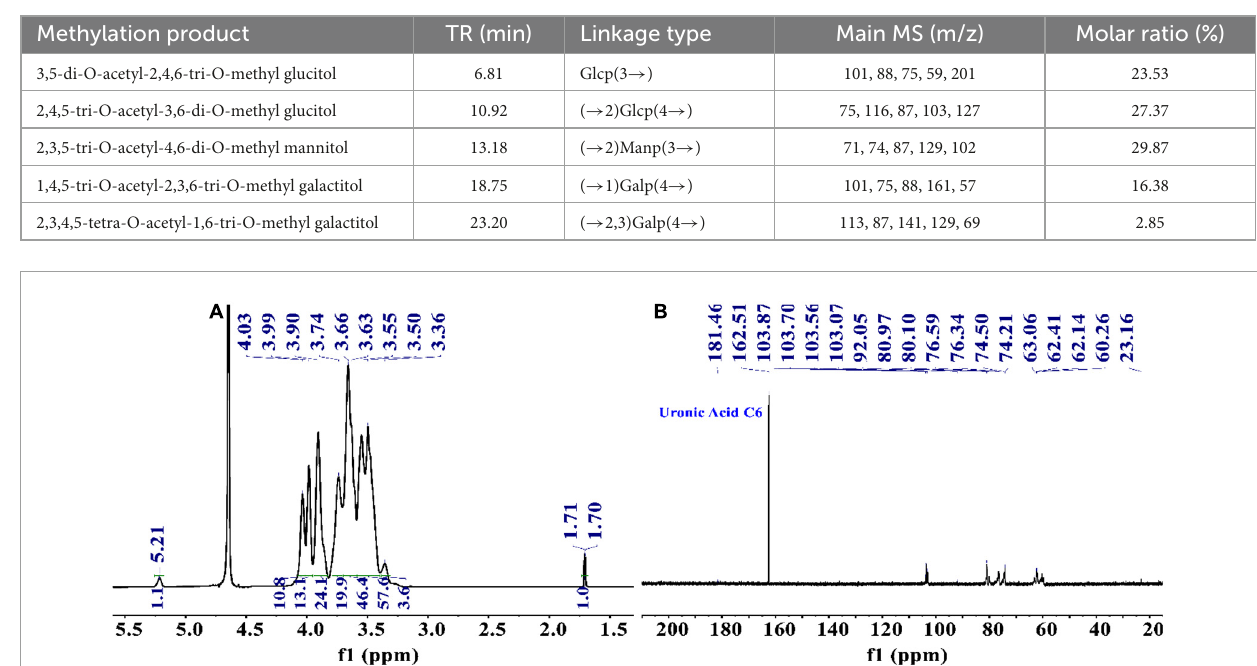
HSQC, HMBC, and NOESY. The complete assignment of PKP2-1 is shown in Table 2